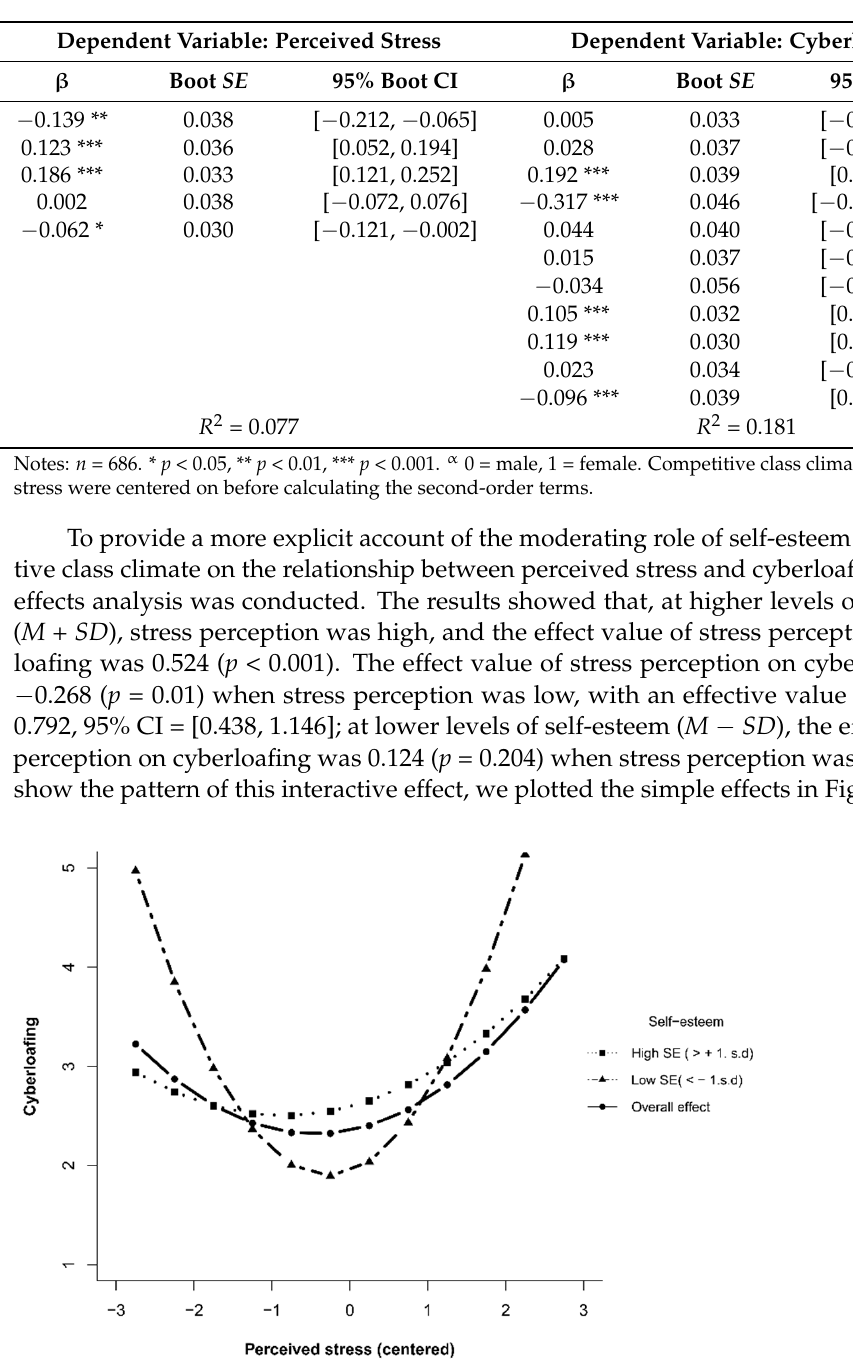
Table 3. Test of the curvilinear moderated mediation model.